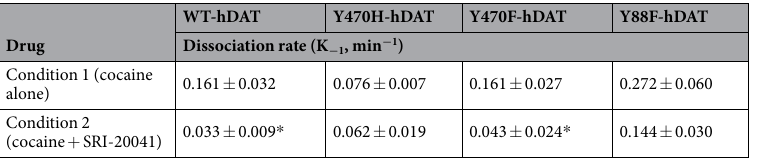
Table 3. Effects of SRI-20041 on cocaine-induced [ 3 H]WIN 35,428 binding dissociation in WT and mutated hDAT. Data are calculated as a percentage of [ 3 H]WIN 35,428 binding dissociation rate in response to cocaine with or without SRI-20041 addition followed by nonlinear regression analyses using a single component dissociation model. Data are presented as mean ± S.E.M. of dissociation rate values from 5–8 independent experiments performed in duplicate. * p < 0.05 compared with the respective condition